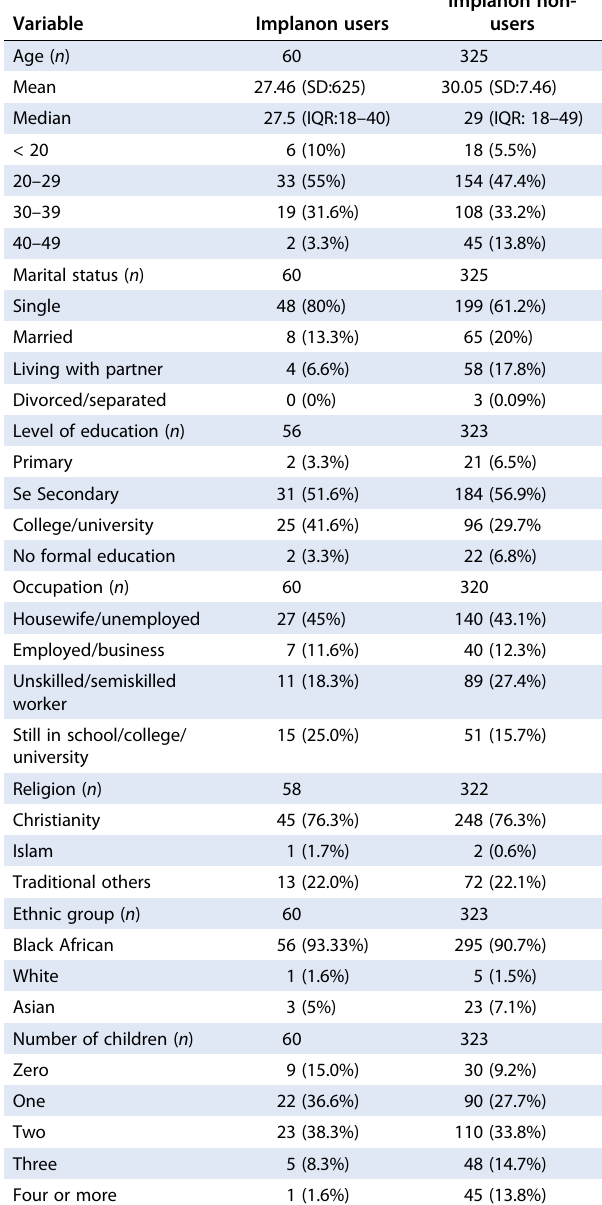
Table 1: Frequency of the proportion of study participants per facility between December 2016 and May 2017 in Ugu (Ugu North Sub District)